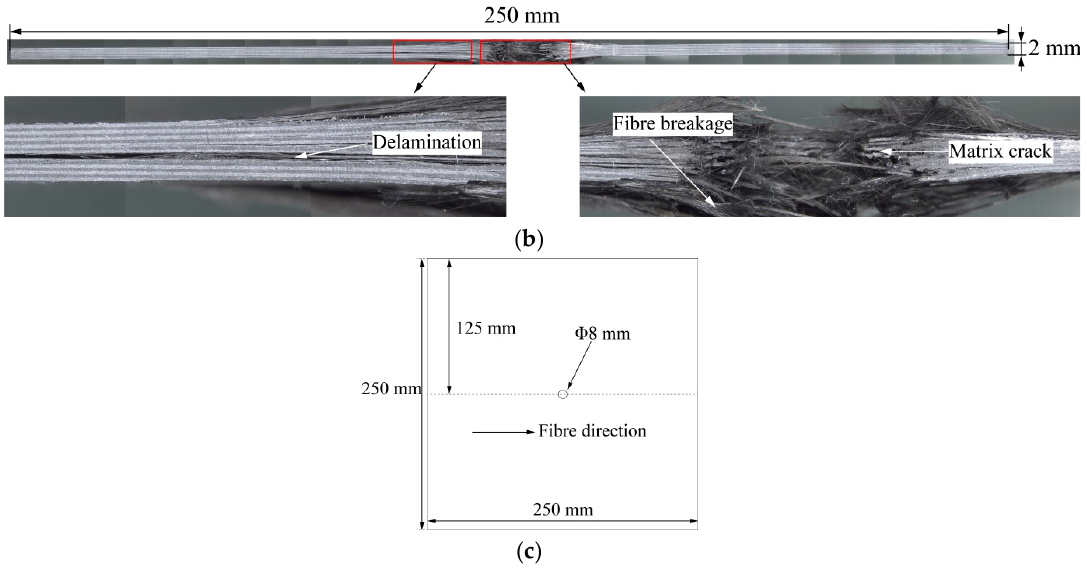
Figure 6. Damage in the fastener hole of the specimens after lightning strikes: ( a ) component C; ( b ) component D. ( c ) Specimen cutting diagram for microscopic evaluation.